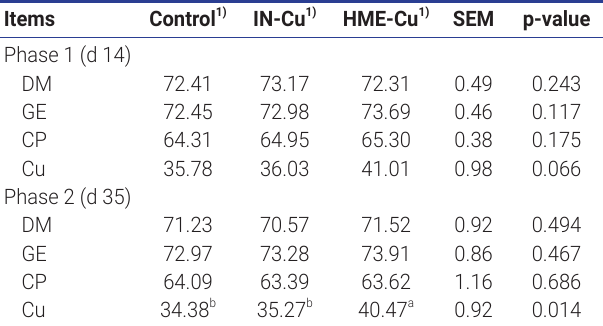
Table 4. Effect of dietary Cu concentrations and sources on digesti- bility of nutrients in broilers